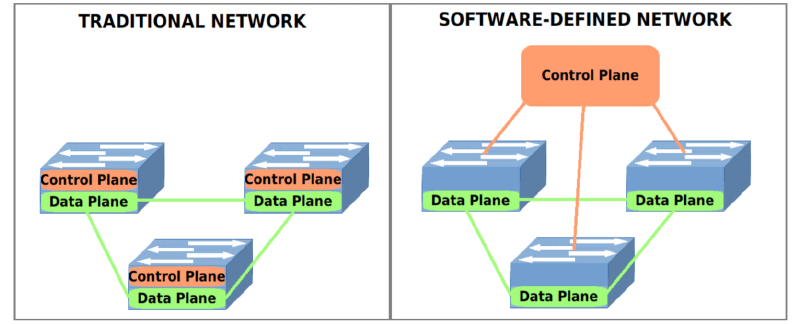
Figure 3. Traditional network versus software defined